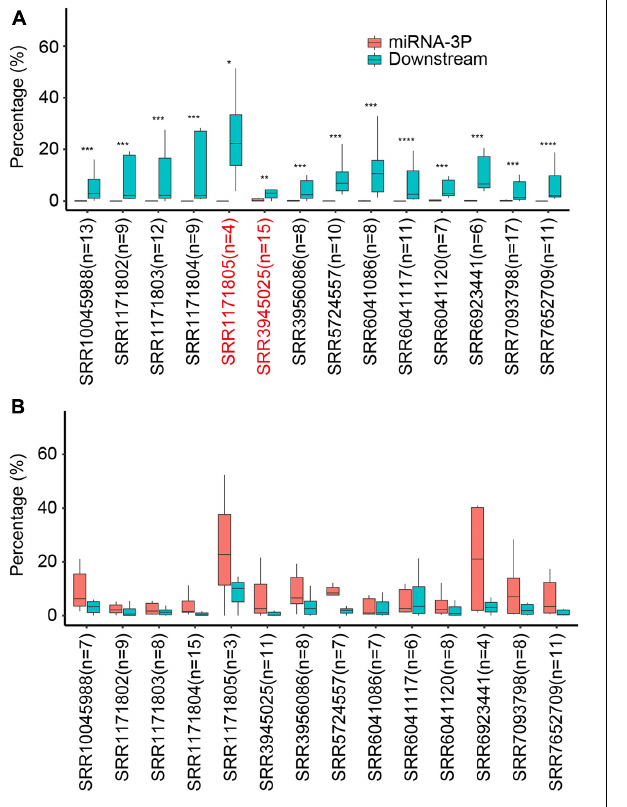
FIGURE 2 | Quality control of miRNA contamination of Arabidopsis Wt Parallel Amplification of RNA Ends (PARE) libraries. (A,B) Relative abundance of miR-3p and downstream PARE reads from known short base-to-loop processed miRNAs (A) or short loop-to-base processed miRNAs (B) pre-determined by Specific Parallel Amplification of RNA Ends (SPARE). Percentage was calculated as reads of miR-3p tags or downstream tags vs. total reads from miR-3p and downstream tags of miRNAs with respective processing modes. For each PARE library, only miRNAs with a percentage of miR-3p or downstream tags > 0.5%, and a sum number > 10 were kept. The number of analyzed miRNAs in each library are indicated in brackets. * p < 0.05; ** p < 0.01; *** p < 0.005, **** p < 0.001 (Wilcoxon test). SRR6923441, SRR6923442, and SRR6923443 were merged under the entry of SRR6923441, owing to low sequencing